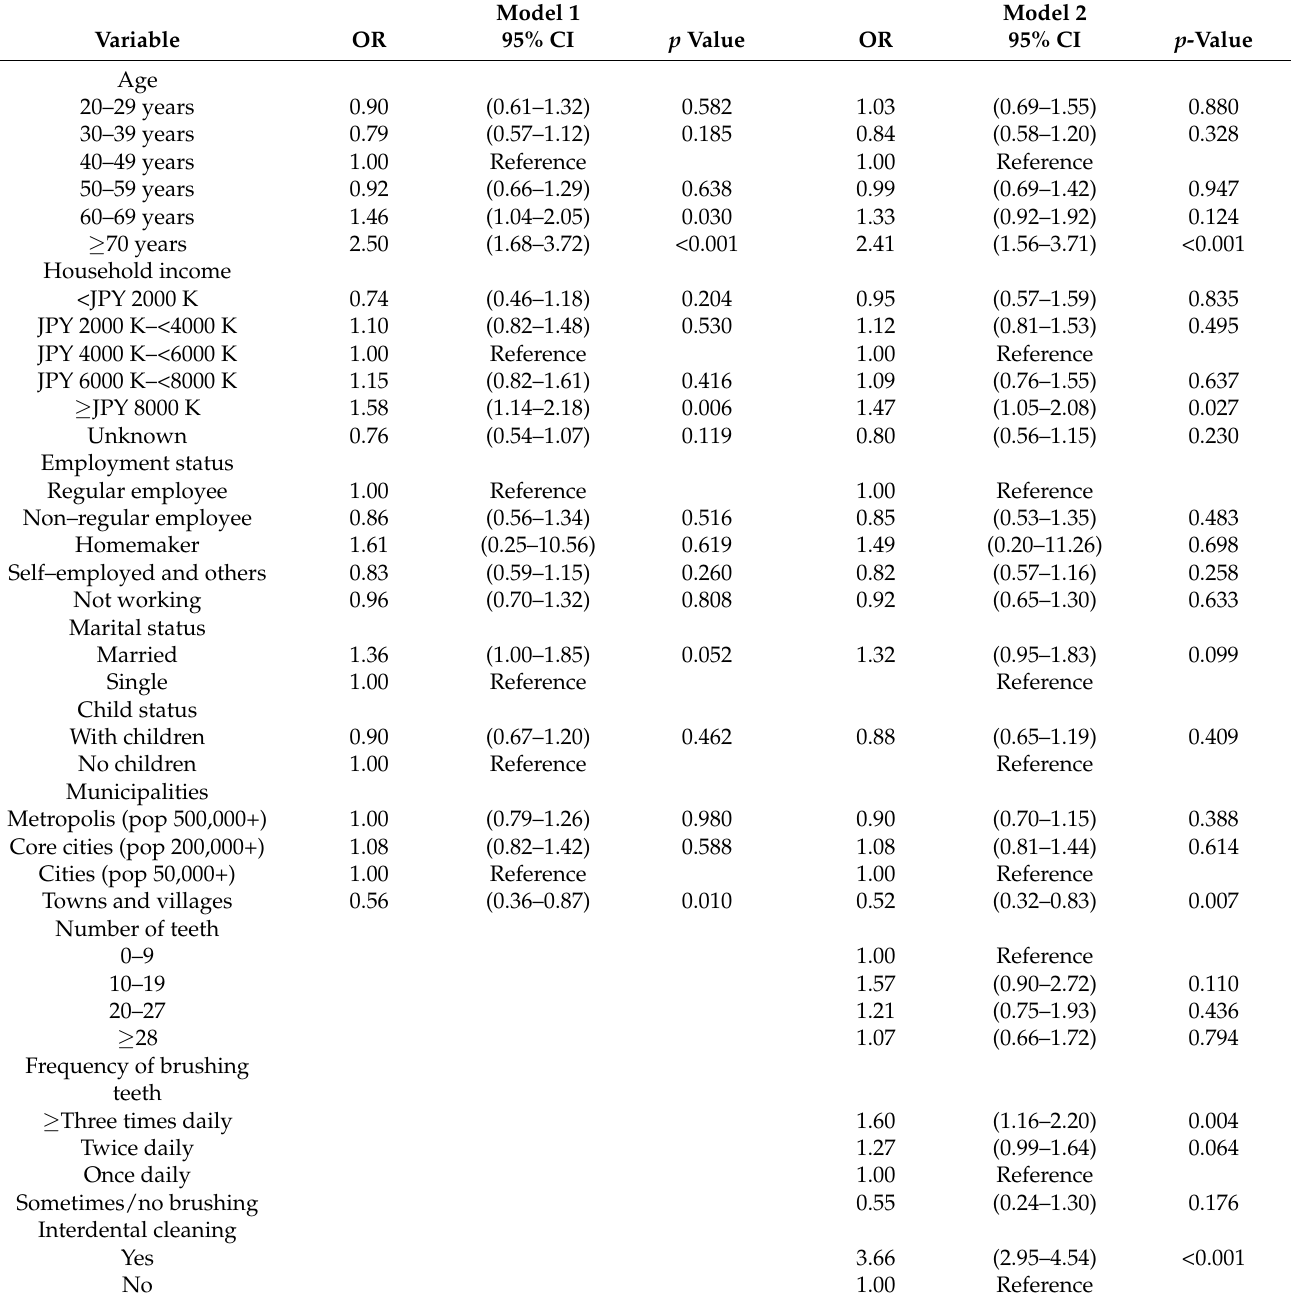
Table 3. Characteristics of the male study participants in the FD